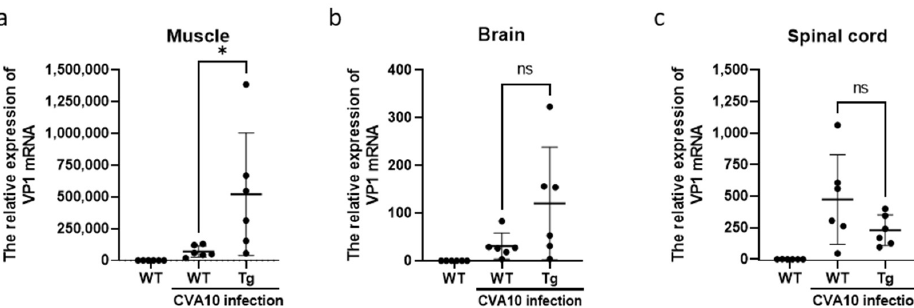
Figure 5. Viral distribution in the tissues and organs of CVA10-infected mice. Twelve-day-old WT and hSCARB2-Tg mice were injected with 1.72 × 10 7 pfu of CVA10 s.c. On day 3, post-viral infection, RNA extracted from the ( a ) muscle, ( b ) brain, and ( c ) spinal cord of the mice were subjected to quantitative RT-PCR analysis using primers specific to the VP1 region. β-actin gene expression in each tissue was used as the internal control. A schematic representation of the VP1 gene expression and the statistical average from six mice per group, as described in the Materials and Methods section, is shown. The symbols * and ns were used to indicate p < 0.05 and no significant difference, respectively.